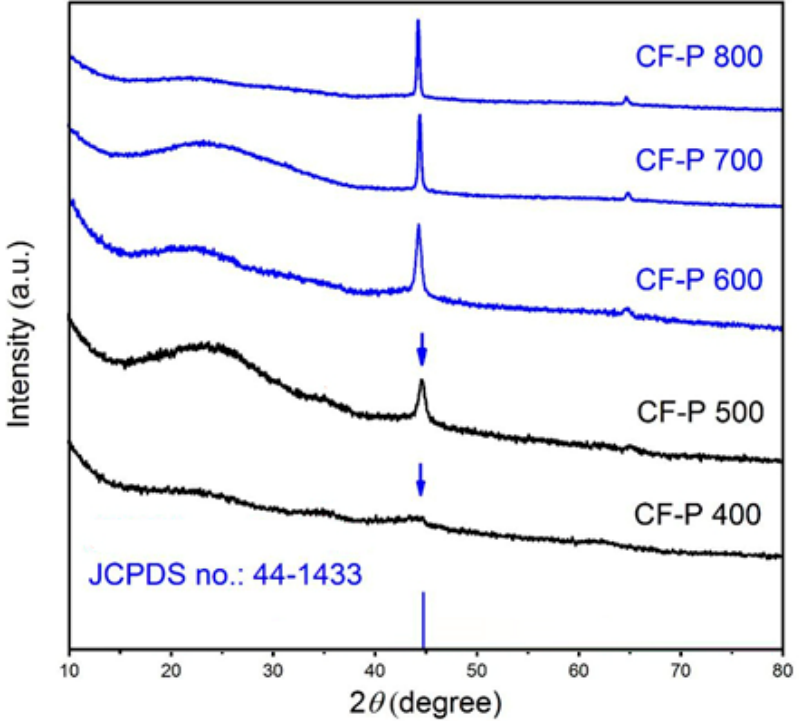
Figure 3. XRD patterns of samples CF-400, CF-500, CF-600, CF-700 and CF-800. The area of the XRD peak indicates the crystal content; the larger the area, the higher the crystal phase content. A narrow peak indicates a large grain size, which can be calculated by Scherrer’s formula. The XRD pattern peak is high if the relative background strength is high, indicating a high crystal phase content, consistent with the area indicating the crystal phase content [23].